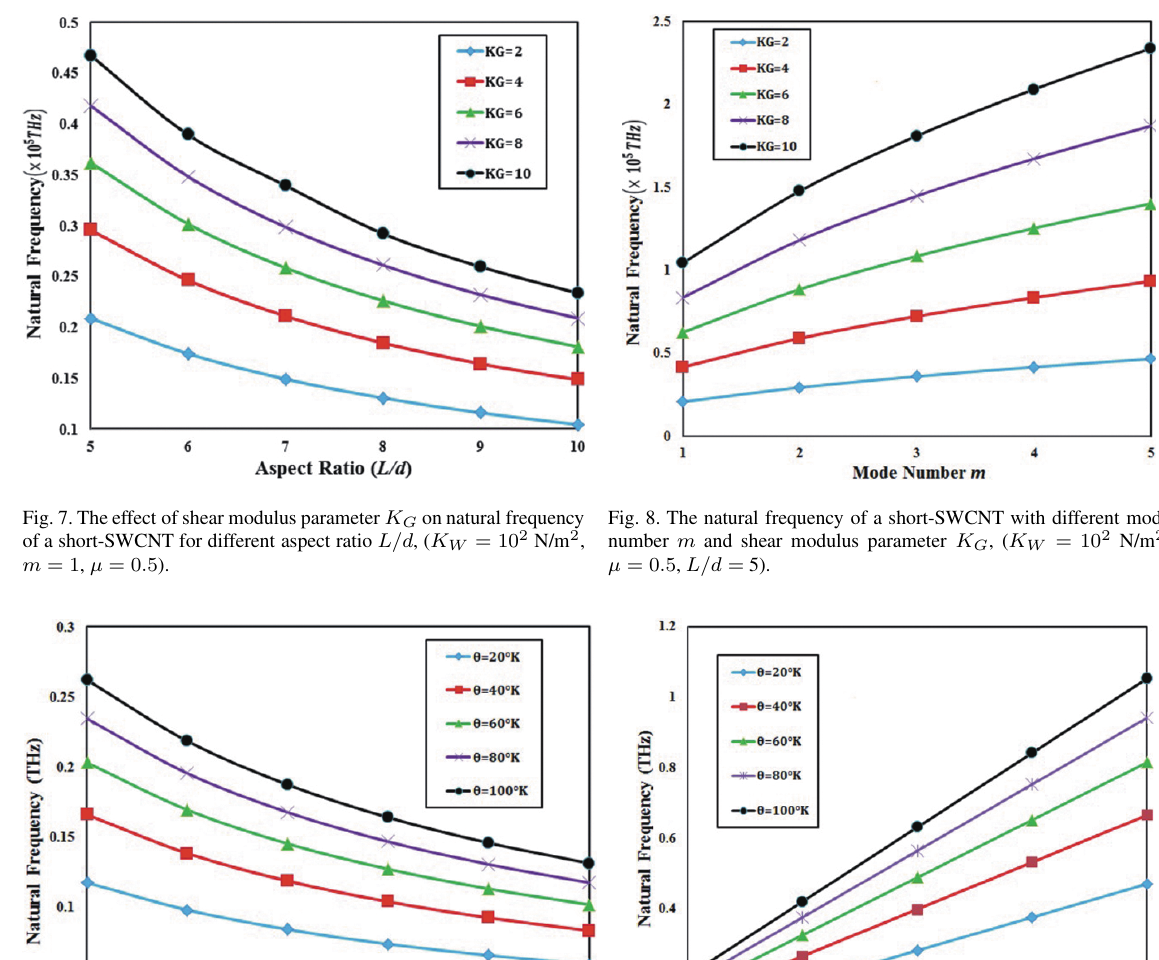
Fig. 9. The effect of temperature on frequency of a short-SWCNT with Fig. 10. Change of mode number m on natural frequency for different different aspect ratio L/d , ( K G = K W = 0, m = 1, μ = 0 . 5 ). temperature, ( μ = 0 . 5 , L/d = 5 , K W = K G = 0 ). ¯ N = Case (3). K G = 0 ,